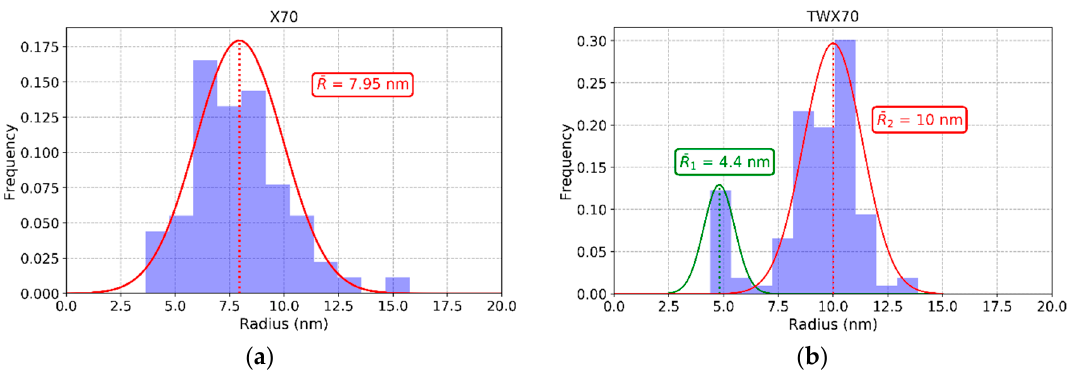
Figure 3. Measured size distributions of nano-sized precipitates from SEM images for ( a ) X70 steel (82 particles) and ( b ) TWX70 steel (112 particles).